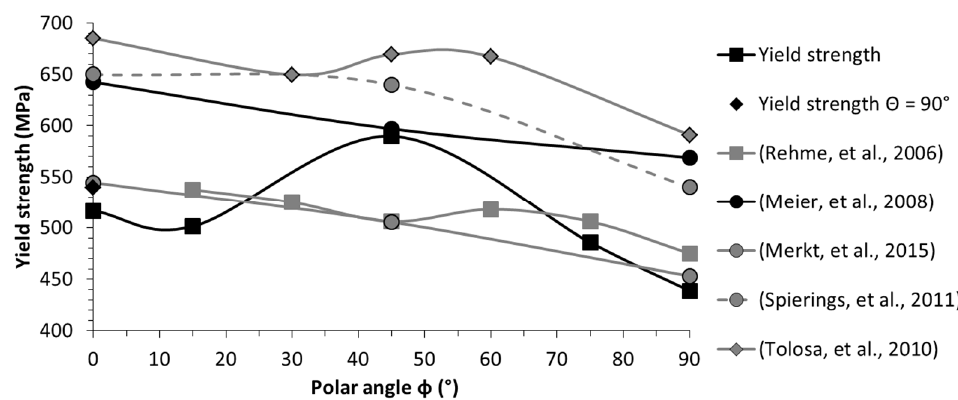
Figure 6. Orientation dependency of the yield strength; comparison with reported results [4,14,18,20,21].